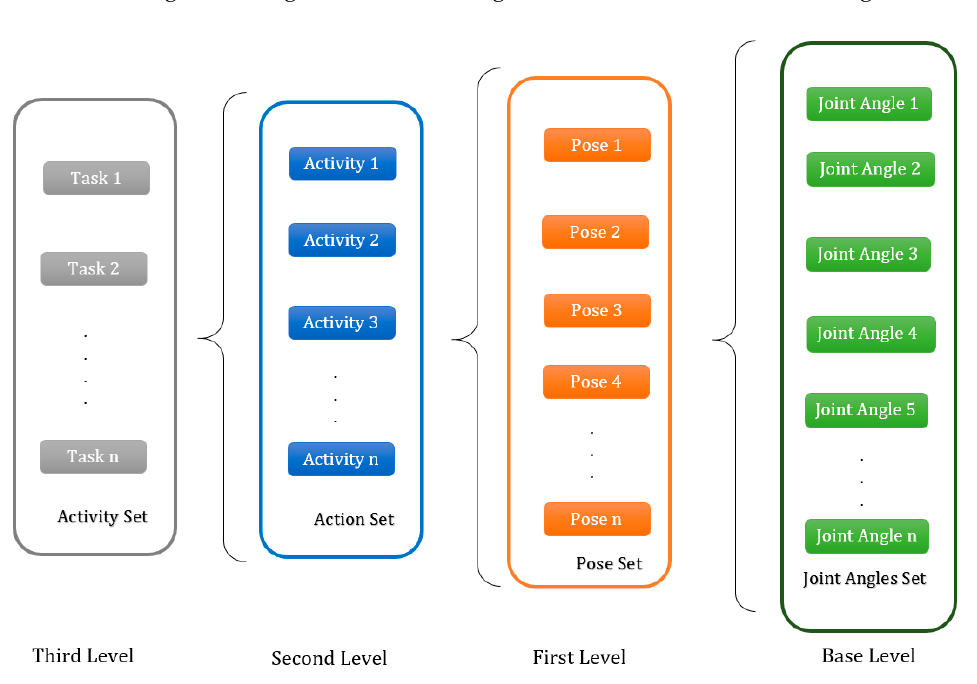
Figure 2. Learning activities for robots using a decomposition framework.